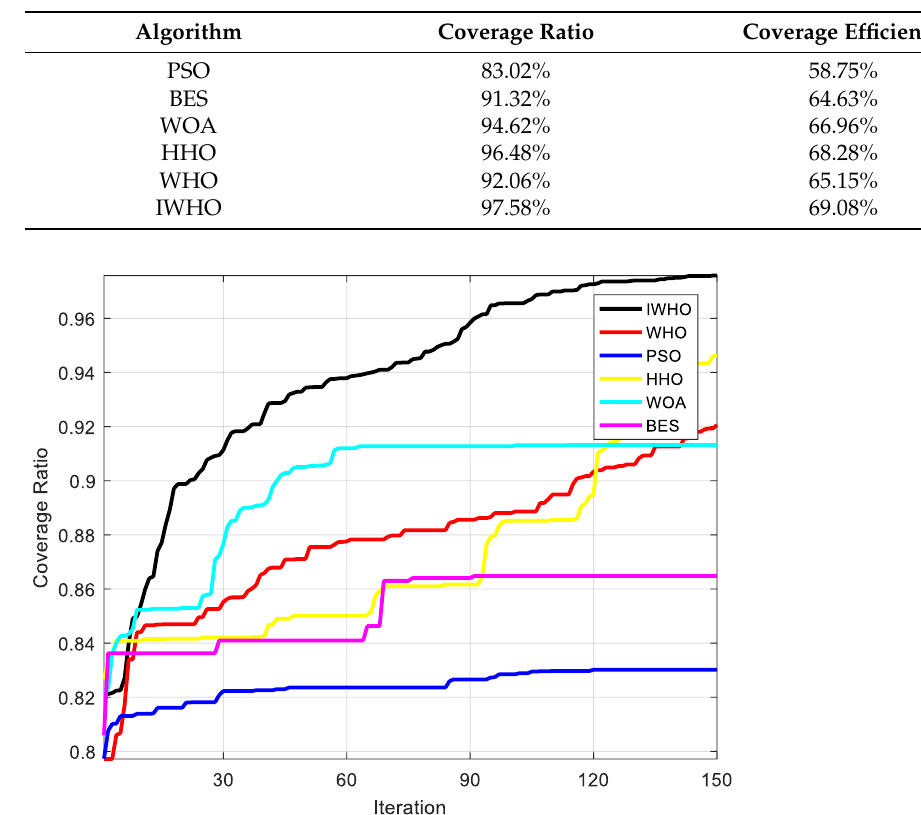
Table 10. Comparison of TABC and IWHO experimental results.